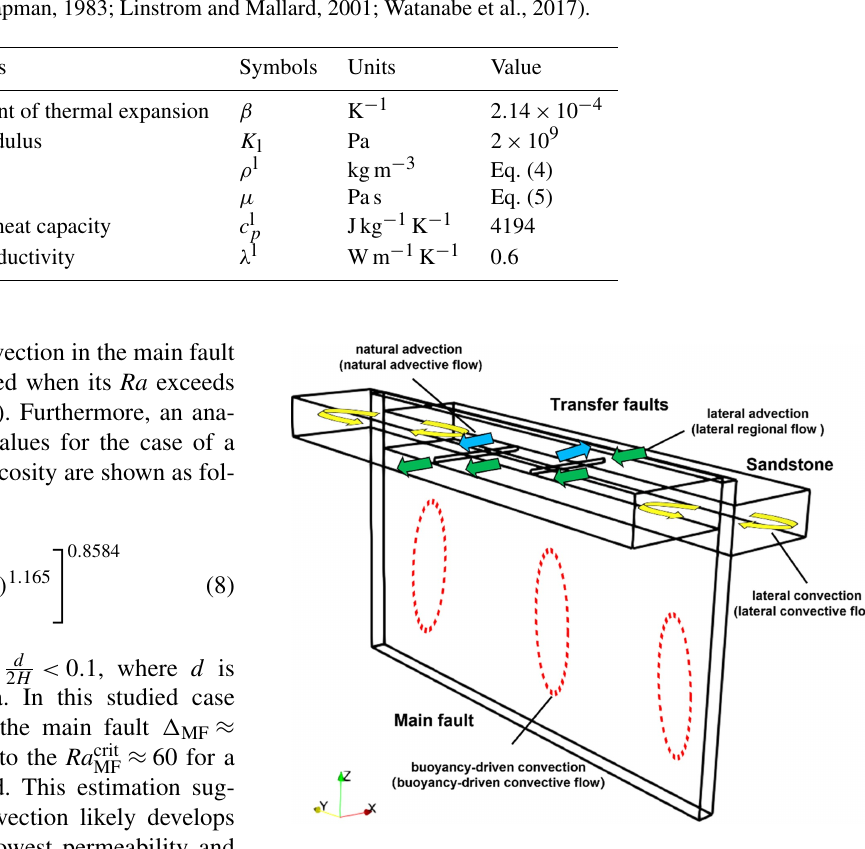
Figure 3. Schematic representation of the modelled 3D main fault. Four different types of fluid-flow pathways involving the lithologi- cal units are illustrated. The 3D main fault accounts for the relative displacement (i.e. 600m) of the surrounding lithological units. Only one transfer fault is shown on both sides of the main fault for sim-